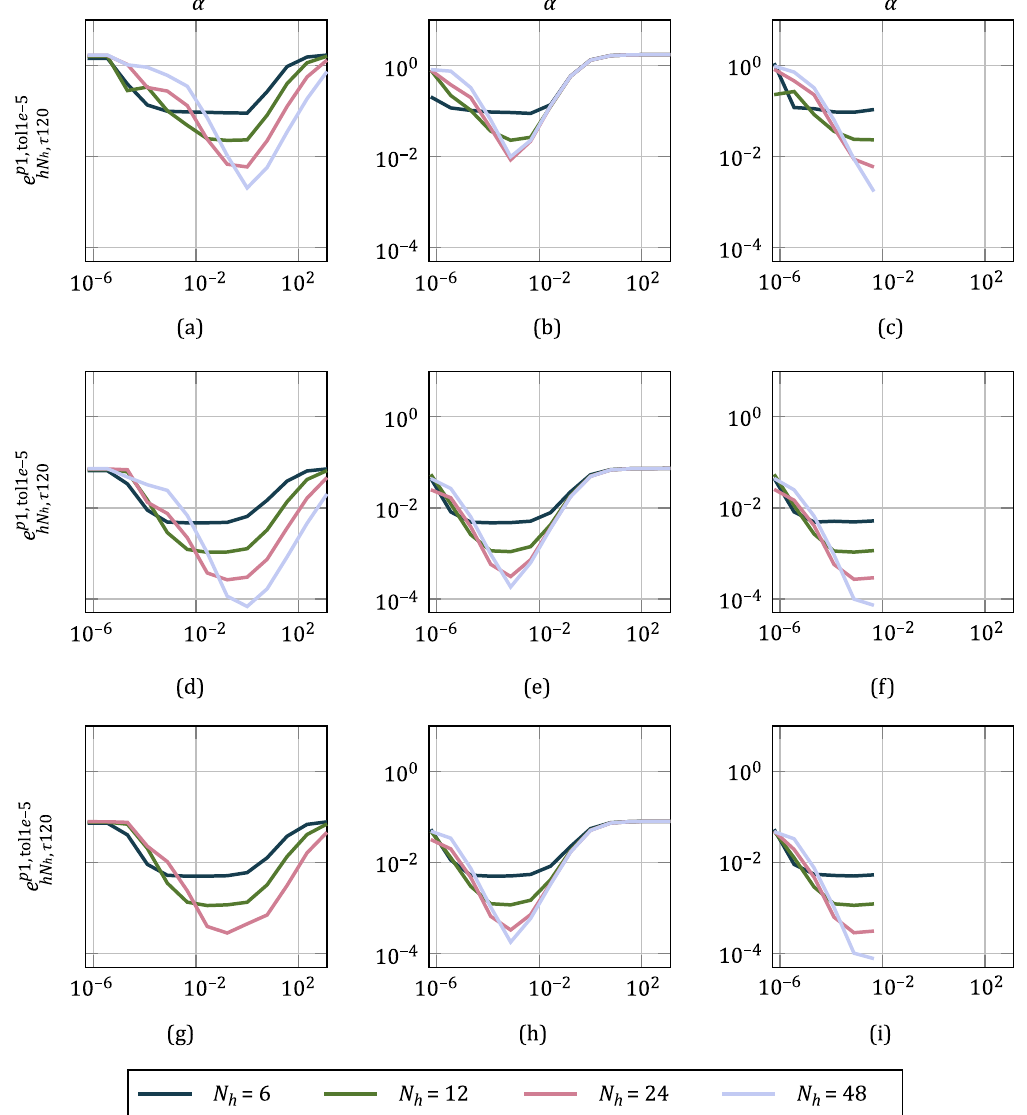
Figure 5. Penalty schemes and inexact solves, cf. the section Parameter studies for the penalty schemes . The error e p 1 ; tol 1 e (cid:3) 5 varying space discretizations N h versus the penalization parameter α for the schemes pena (left), pero (middle), and nits (right), where the occurring algebraic equations are solved via GMRES up to an residual of 10 (cid:3) 5 . The fi rst row of plots (a – c) corresponds to Test Case 1, the middle row (d – f) to Test Case 2, and the bottom line (g – i) to Test Case